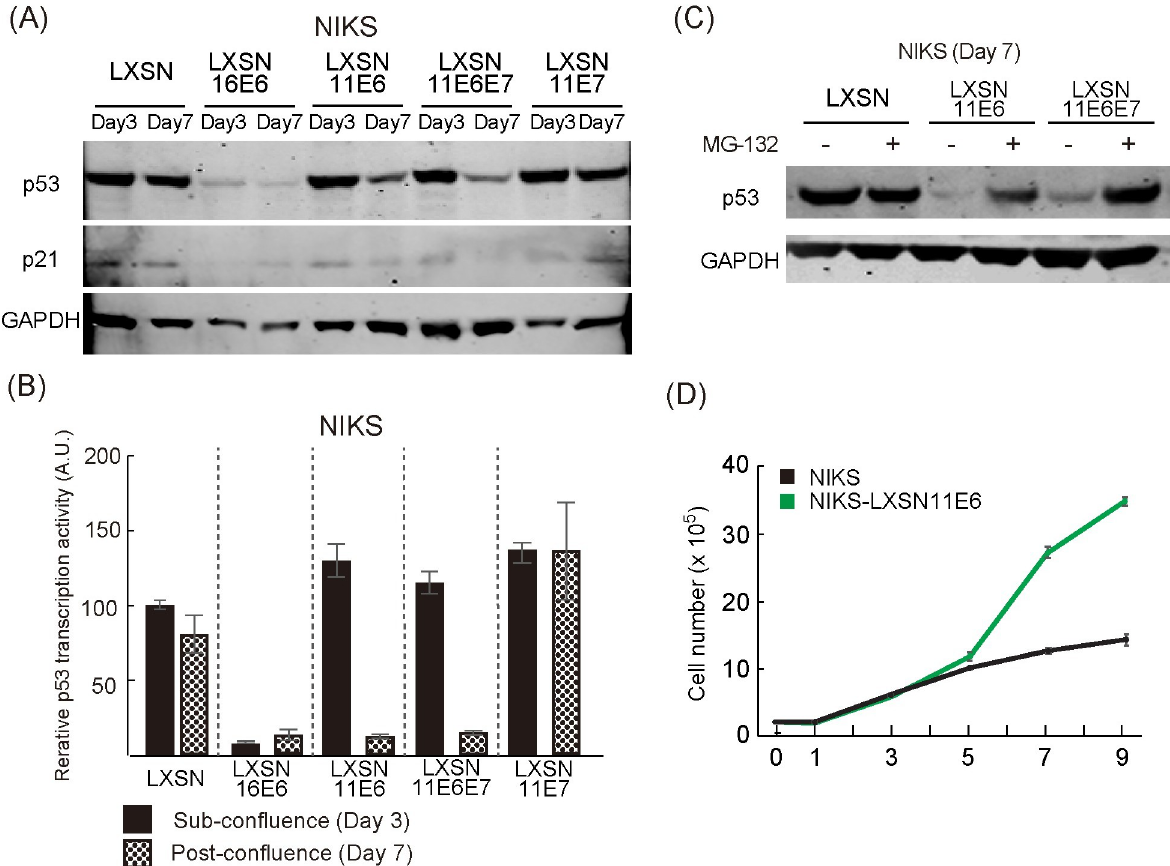
Fig 8. HPV11 E6 drives a reduction in p53 levels only at post-confluence. (A) Whole cell extracts of NIKS or NIKS expressing 16E6, 11E6, 11E6/ E7 and 11E7 at day 3 and 7 were used to assess the levels of p53 and p21 by western blot. (B) A p53 reporter assay was performed to assess p53 transcriptional activity. Each assay was carried out either at day 3 and 7 using NIKS or NIKS expressing 16E6, 11E6, 11E6E7 and 11E7. The activity of firefly luciferase normalized using the activity of Renilla luciferase. The p53 transcriptional activity of NIKS at day 3 was set at 100%, and other measurements normalised to this. (C) 1nM of the proteasome inhibitor, MG-132, or an equal volume of the carrier (dimethyl sulfoxide) was added to NIKS or NIKS expressing 11E6 or 11E6E7, and incubated for 3 hrs. Whole cell extracts were used to assess the level of p53 by western blotting. The loss of p53 protein was restored by proteasome inhibition. (D) Elevation in growth rate in NIKS expressing 11E6, in comparison with the parental NIKD-LXSN cells. 11E6 has similar effects on cell growth, particularly post-confluence.